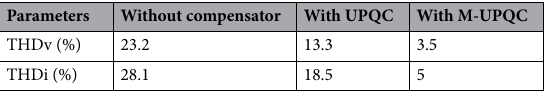
Table 4. The harmonic output voltage and current values.